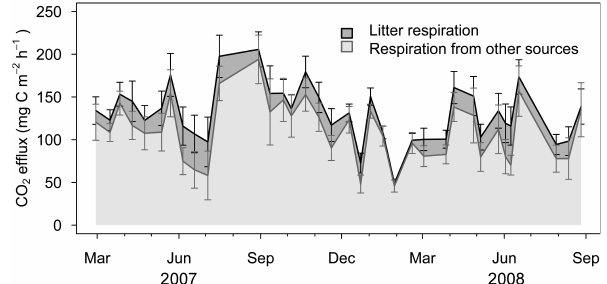
Fig. 5. CO 2 efflux from leaf litter contribution study in the control plots. The dark grey color indicates the CO 2 production derived from leaf litter, while the light grey color denotes the CO 2 produc- tion from within the soil profile from other sources. The error bars indicate the standard error of the six measurements per sampling